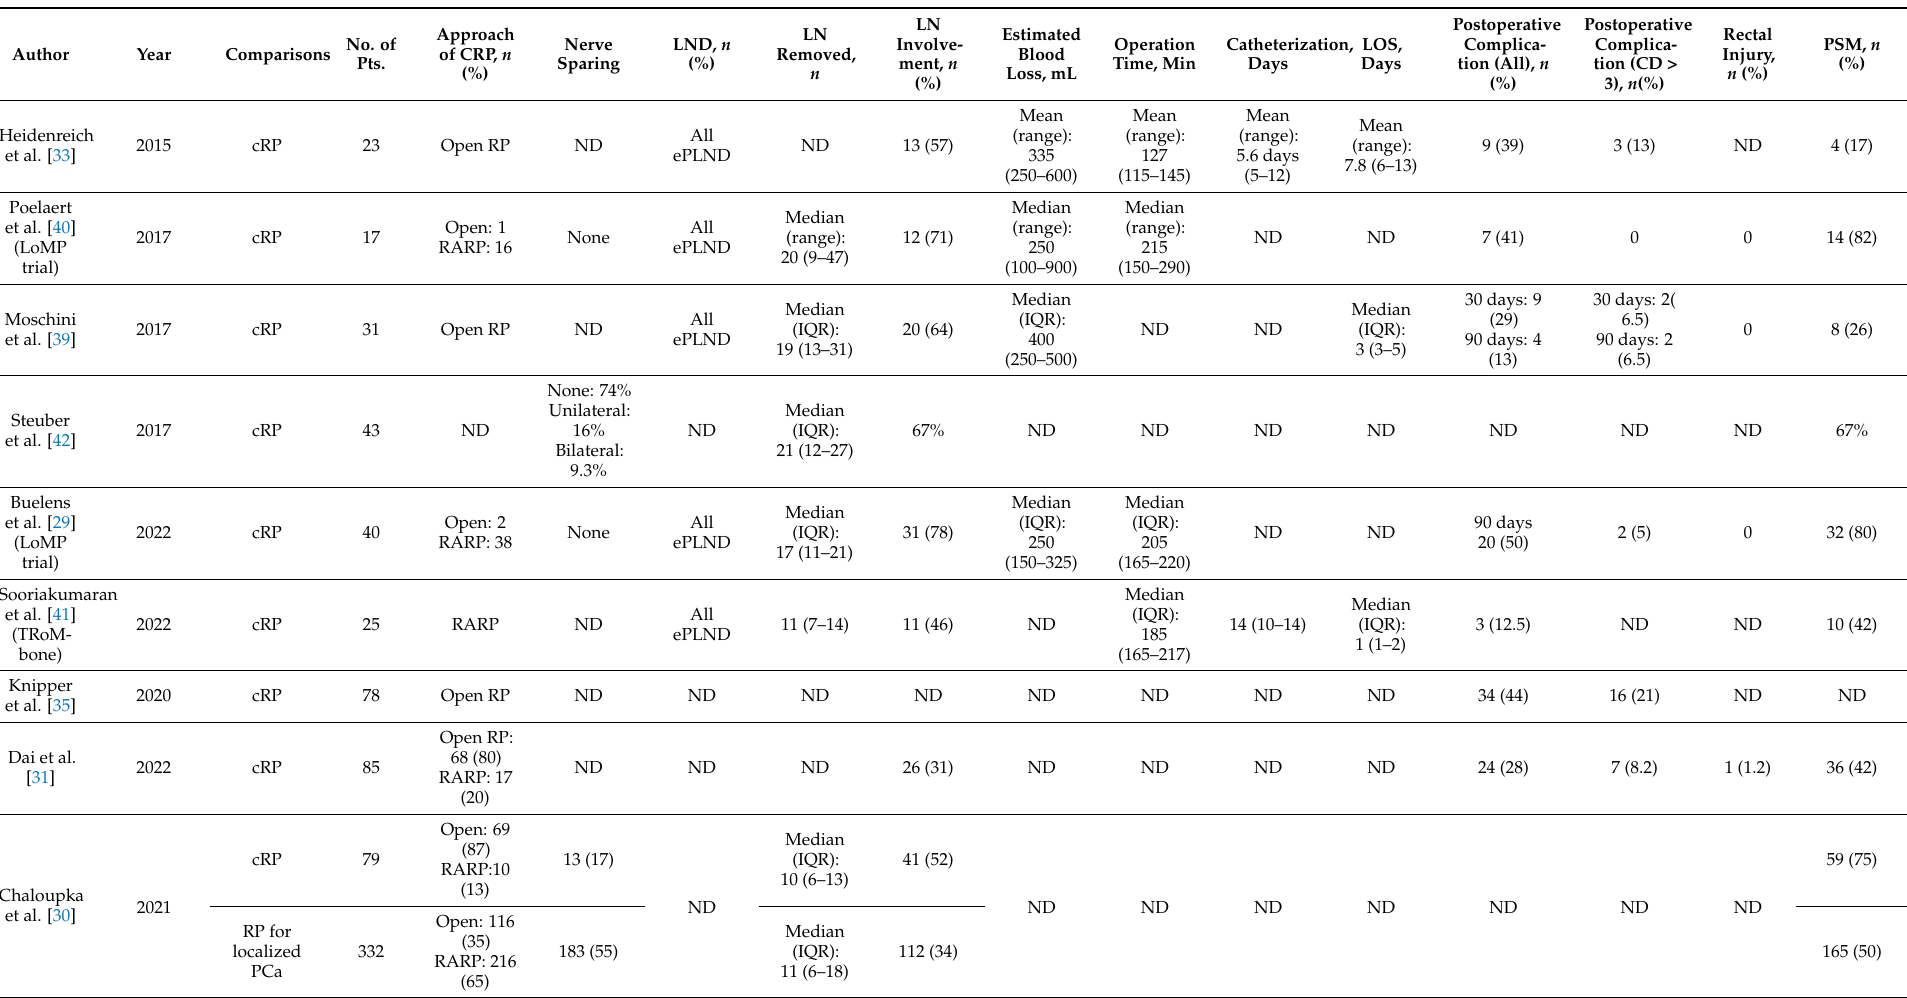
Table 3. Perioperative outcomes following